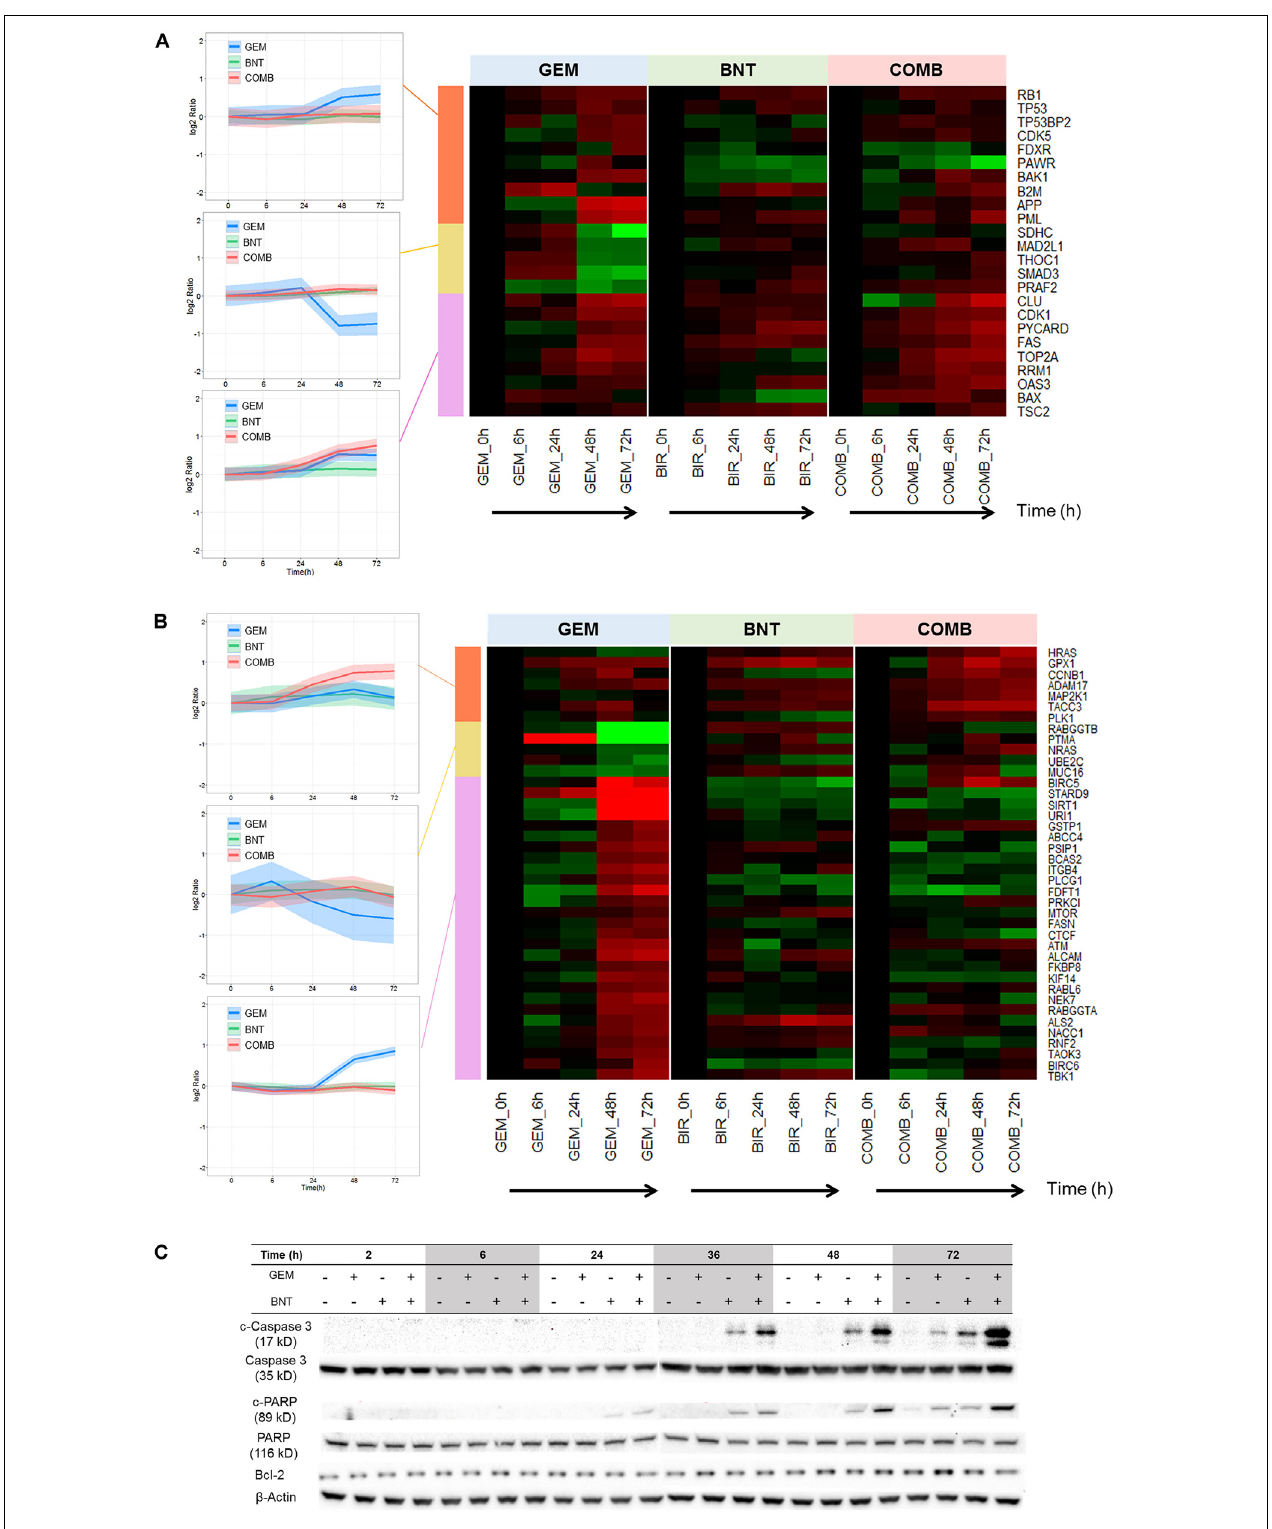
FIGURE 5 | Pathways related to apoptosis affected by gemcitabine/birinapant treatment. Significantly altered proteins involved in (A) pro-apoptotic and (B) anti-apoptotic responses that were quantified by proteomic analysis are summarized in the heat map plot. (C) Western blot analysis validating changes in key apoptosis-related proteins. Clustering of proteins and colors are defined in the Figure 3 legend. The proteins relevant to each gene name in the heat map are summarized in Supplementary Table S1.